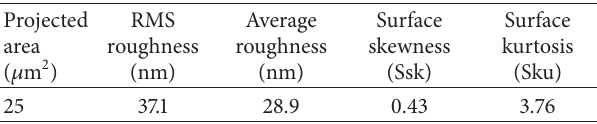
Table 3: Morphological information of TiO immobilized on glass